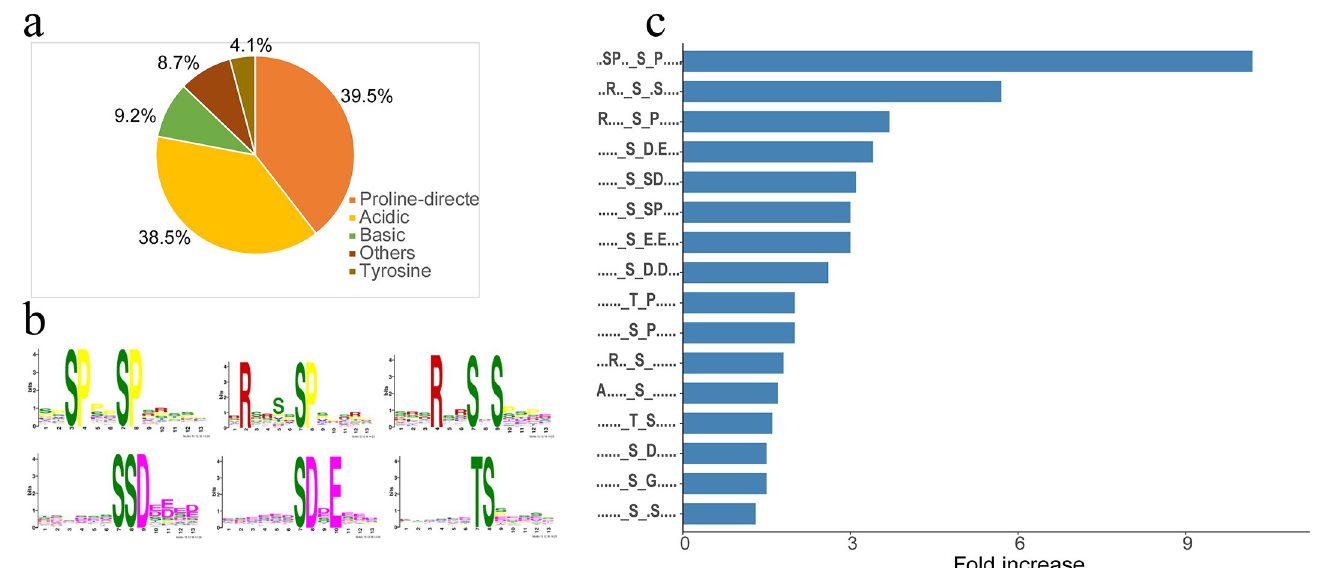
Fig 5. Phosphorylation-specific motifs identified by the Motif-X algorithm. ( a ) The four kinase classes based on the Motif-X algorithm. ( b ) Motif analysis of phosphorylation sites. ( c ) Several kinases may play key roles in lettuce bolting.